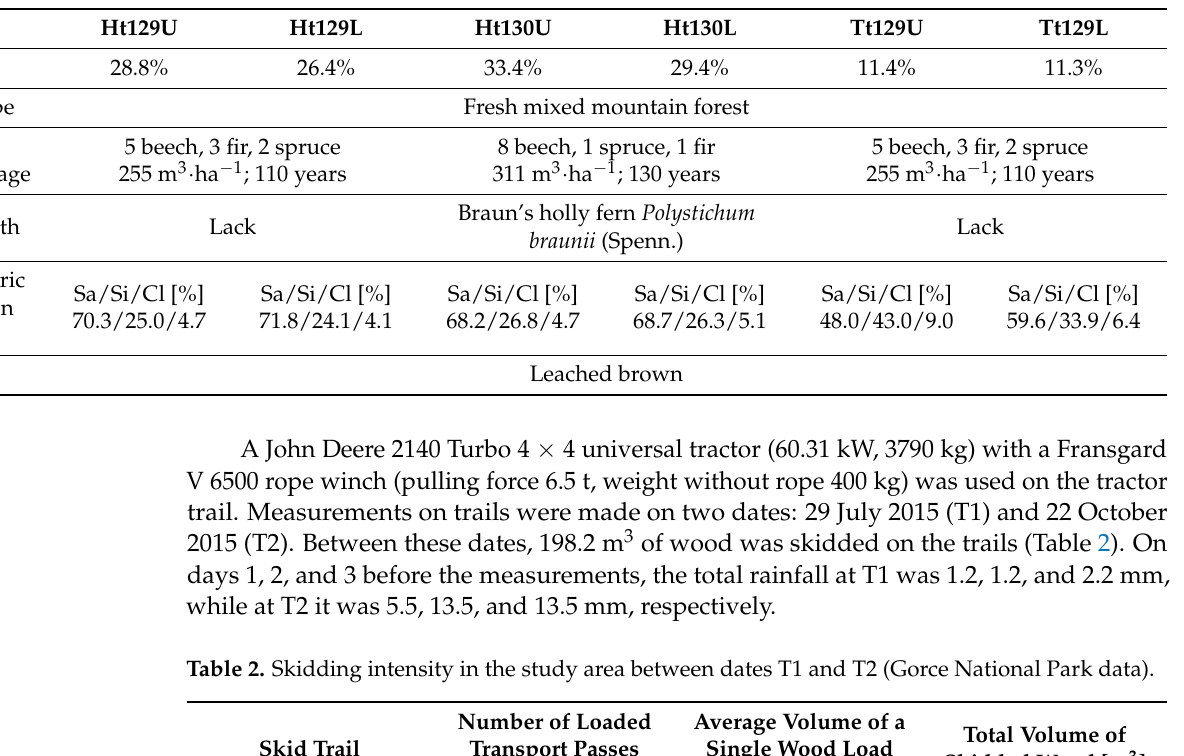
Table 1. Characteristics of the trails and study area.